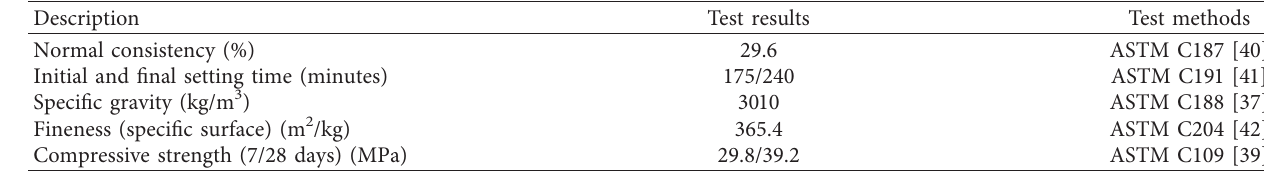
Table 1: Physical properties of Portland composite cement